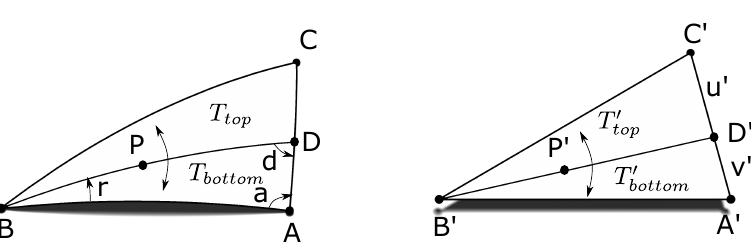
Figure 5. Point P cuts spherical triangle ABC into two parts with a great circle arc emanating from vertex B . Point P (cid:48) within a given planar triangle A (cid:48) B (cid:48) C (cid:48) is solved for such that the relationship in equation 1 holds.